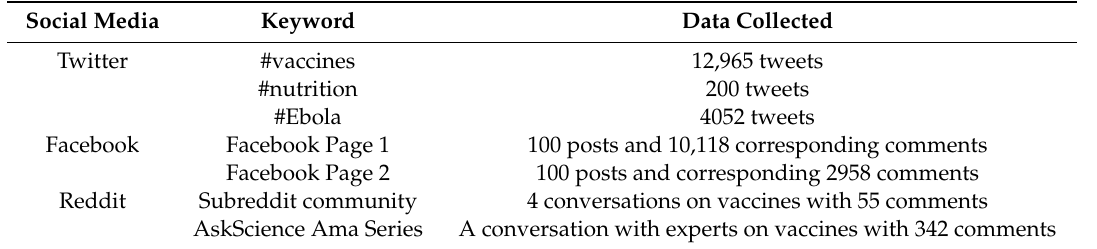
Table 1. Social media data were